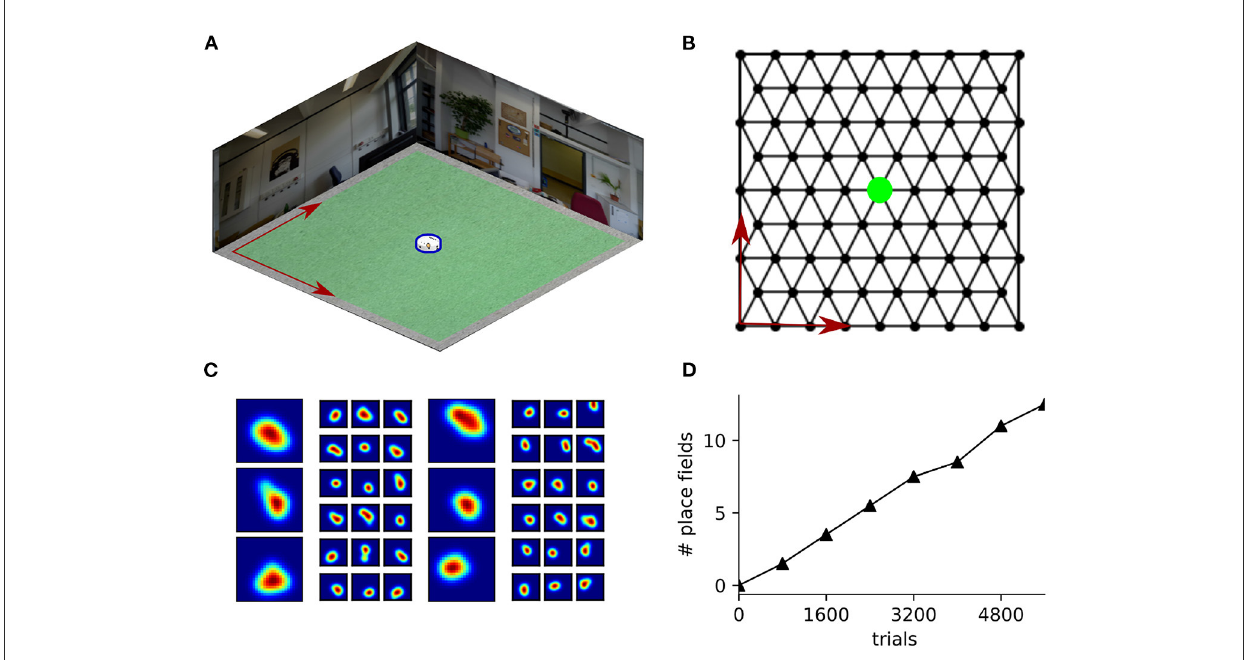
FIGURE8 Analysis of spatial representations using CoBeL-RL. (A) Blender environment used for simulating a navigation task. The agent is marked in blue. (B) Topology graph on which the agent navigates. The location of the unmarked goal is indicated in green. (C) Example place cells emerging in the simulation. The large maps show the place field activity averaged over all head directions and the adjacent six smaller maps show the corresponding activity at each head direction, spaced 60 ◦ apart. (D) Evolution in number of place fields with learning trials.